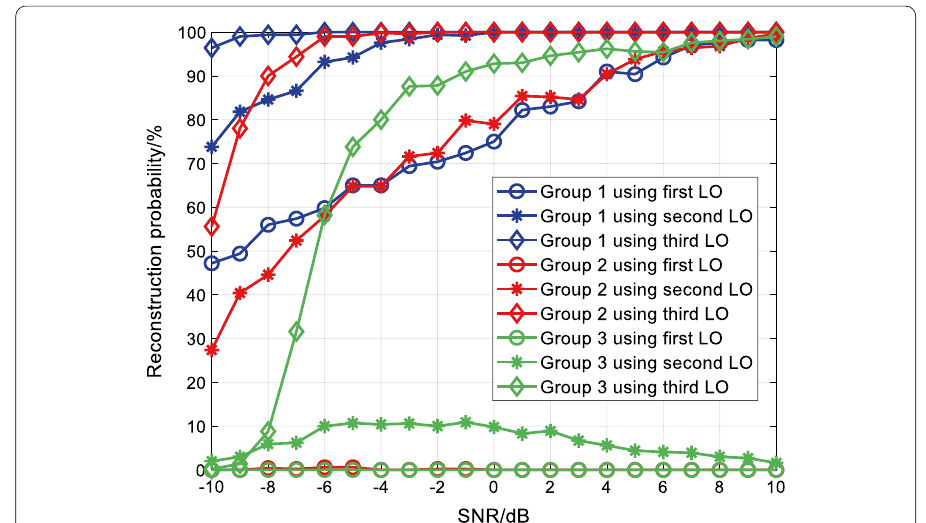
Fig. 7 Reconstruction probabilities of multiple signals using different LO